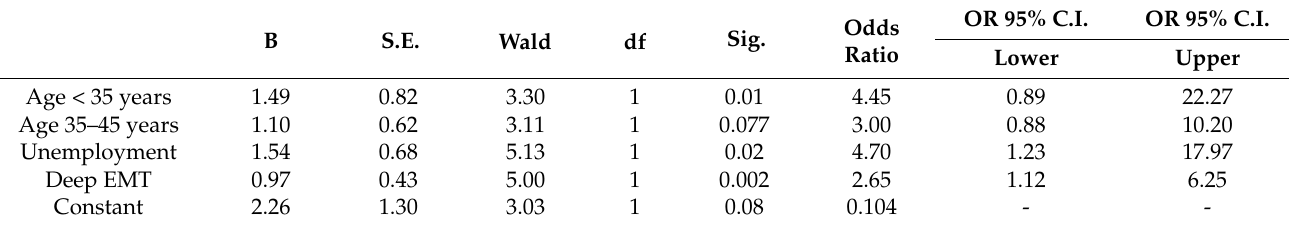
Table 6. Logistic regression model.